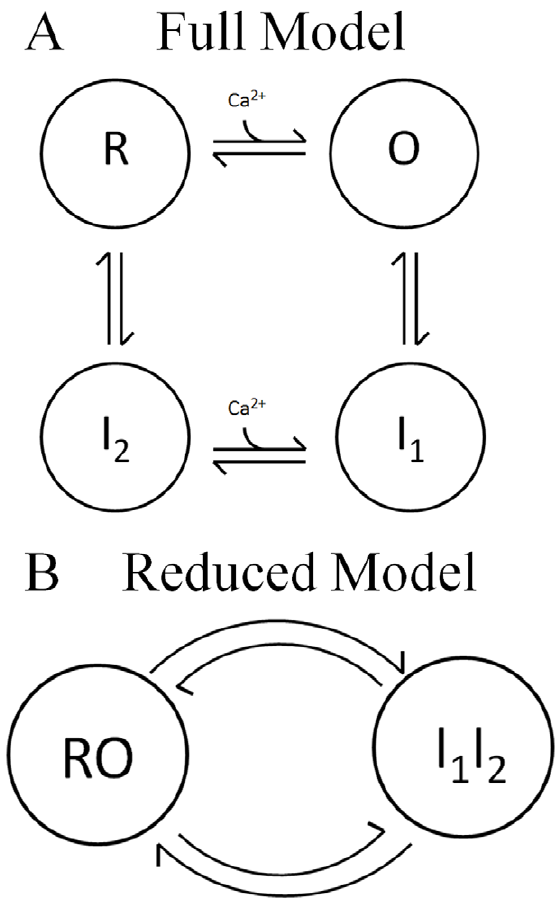
Figure 8. The state model used to derive the 4-state RaM model. A) The full 4-state model is pictured where R , O , I 1 and I 2 represent the resting state, open state, 1st inhibited state and 2nd inhibited state, respectively. B) For the reduced form, it is assumed that states R and O and I 1 and I 2 are in rapid equilibrium with each other. With this assumption, the 4-state model is reduced to a 2-state model where RO and I 1 I 2 represent the resting-open state and sum-total inhibited state, respectively. Applying conservation (i.e. RO + I 1 I 2 =1), the 2-state model is further reduced to a single ordinary differential- algebraic